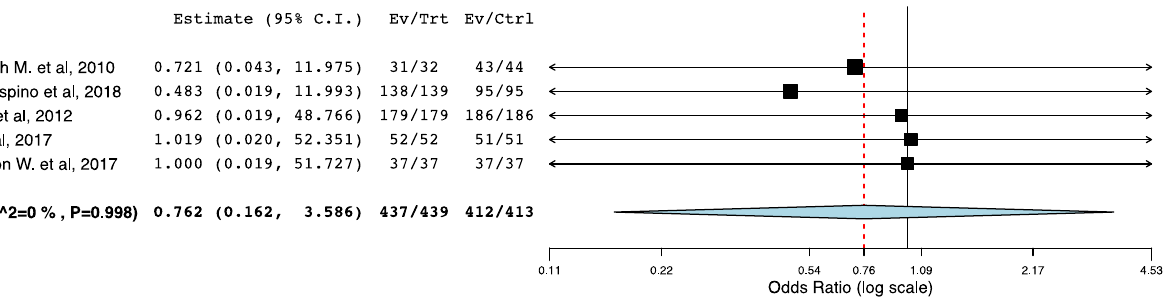
Figure 11. Forest plot: one-year patient survival (ERAS vs. traditional perioperative care).